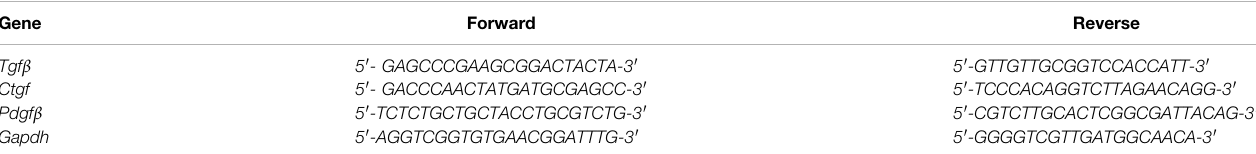
TABLE 1 | Primer sequences used for quantitative qPCR.